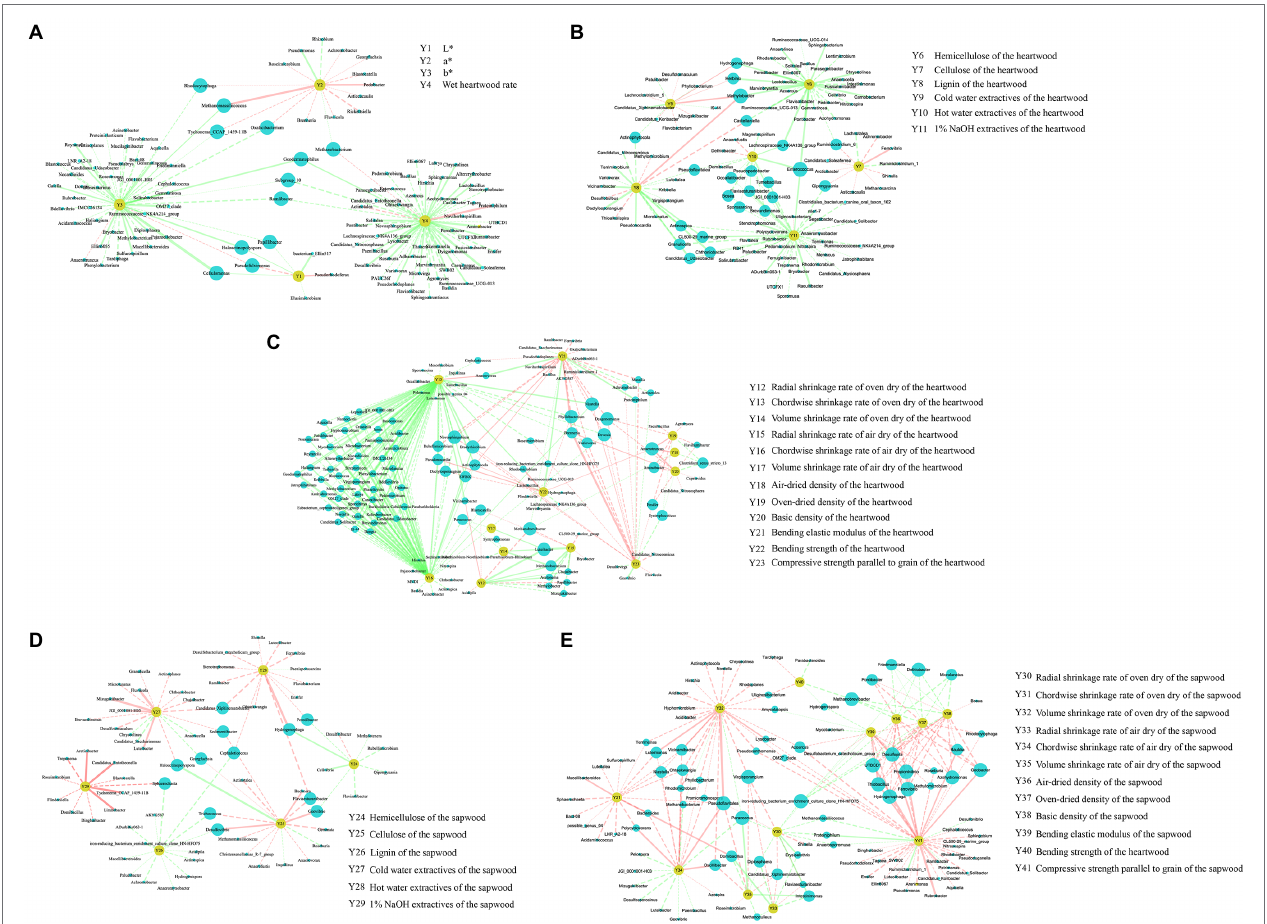
FIGURE 8 | Spearman correlation network diagram of the endophytic bacteria and the chroma value, wet heartwood rate, and the wood properties. (A) Spearman correlation between the heartwood endophytic bacteria and the chroma value and wet heartwood rate; (B) Spearman correlation between heartwood endophytic bacteria and the chemical properties of the heartwood; (C) Spearman correlation between the heartwood endophytic bacteria and the physical and mechanical properties of the heartwood; (D) Spearman correlation between the sapwood endophytic bacteria and the chemical properties of sapwood; (E) Spearman correlation between sapwood endophytic bacteria and the physical and mechanical properties of sapwood. The blue nodes represent the bacterial genus, and the yellow nodes represent the wood property indicators. The size of the blue node represents the number of connections to that node. The solid line represents highly significant, and the dashed line represents significant. The red line represents a positive correlation, and the green line represents a negative correlation. The thickness of the connecting line represents the strength of the